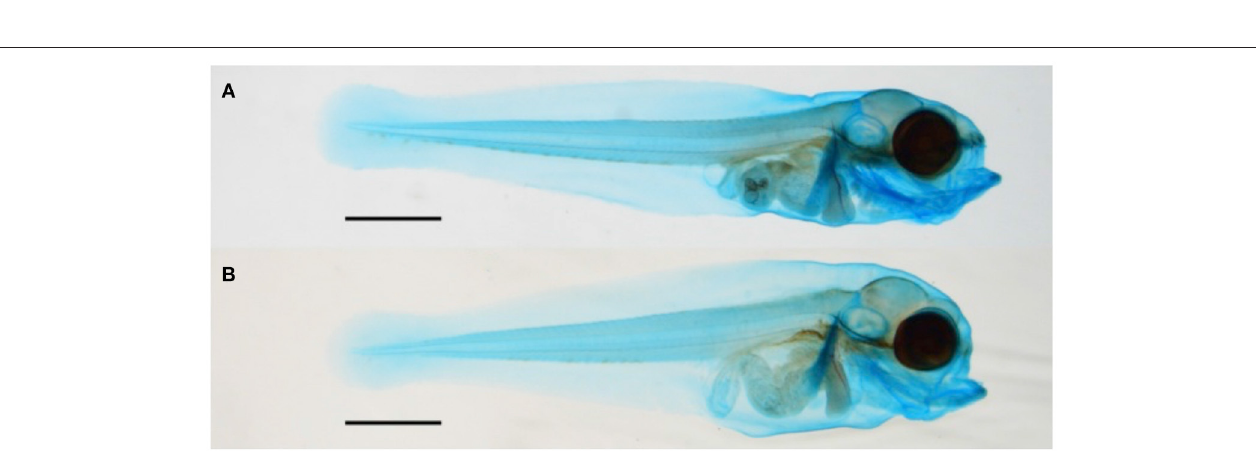
Frontiers in Marine Science |